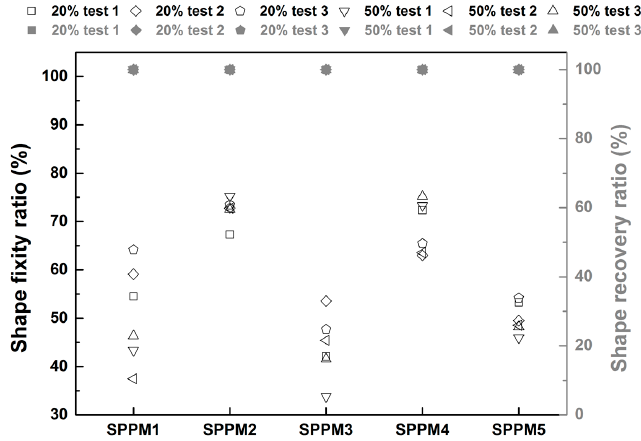
Figure 10. Shape fixity ratio and shape recovery ratio of all SPPM samples (black hollow symbols: shape fixity ratio; grey solid symbols: shape recovery ratio). The applied programming strain in each sample is indicated in % in the legend (top).